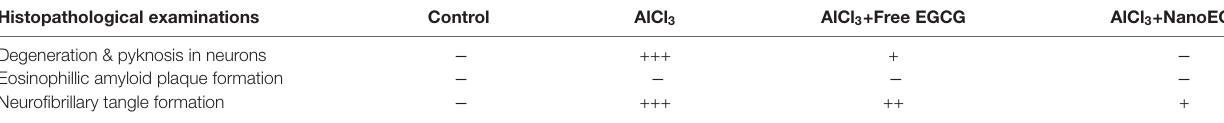
TABLE 2 | Effect of nanoEGCG on the severity of histopathological alterations in the hippocampus of Alzheimeric rat brains.